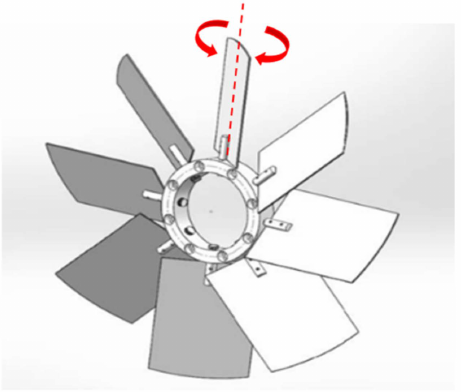
Figure 3. Structure of the swirl distortion